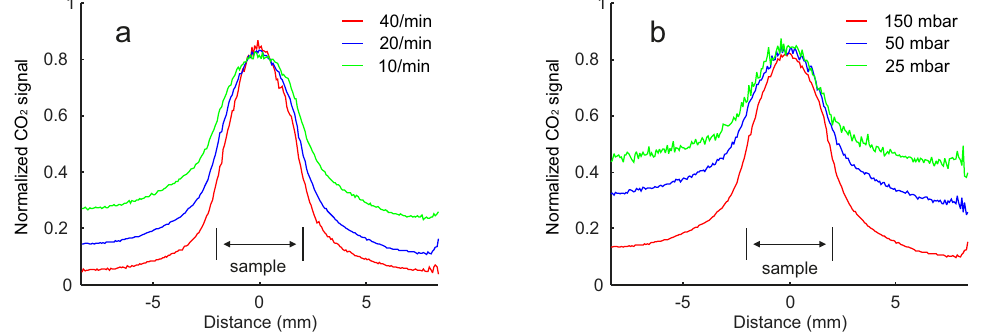
Figure 4. Normalized CO 2 profiles (averaged over five rows) at 0.5 mm above the sample in the MTL regime. ( a ) Chamber pressure at 150 mbar for different gas exchange rates; ( b ) Gas exchange rate of 20 per minute for different chamber pressures.